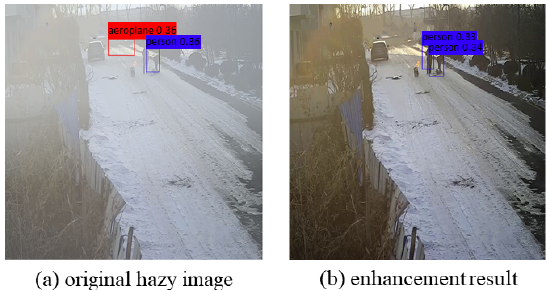
Figure 9. Pre-processing for object detection (Faster R-CNN [52], threshold = 0.3). ( a ): detection on hazy fire scenarios; ( b ): detection on the enhancement result.